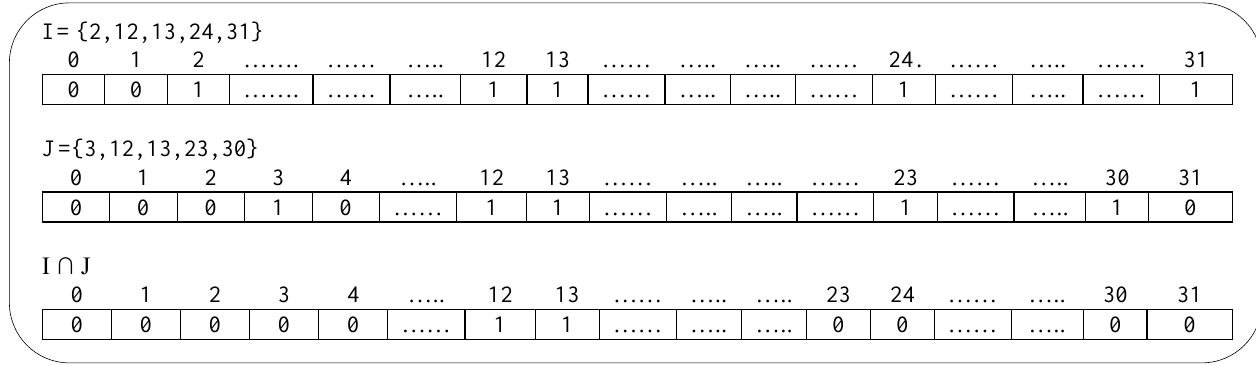
Figure 3. Intersection operation of the itemsets I = {2, 12, 13, 24, 31} and J = {3, 12, 13, 23, 30}. The set difference operation for the itemsets I ={2, 12, 13, 24, 31} and J ={3, 13, 23, 30} is shown in Figure